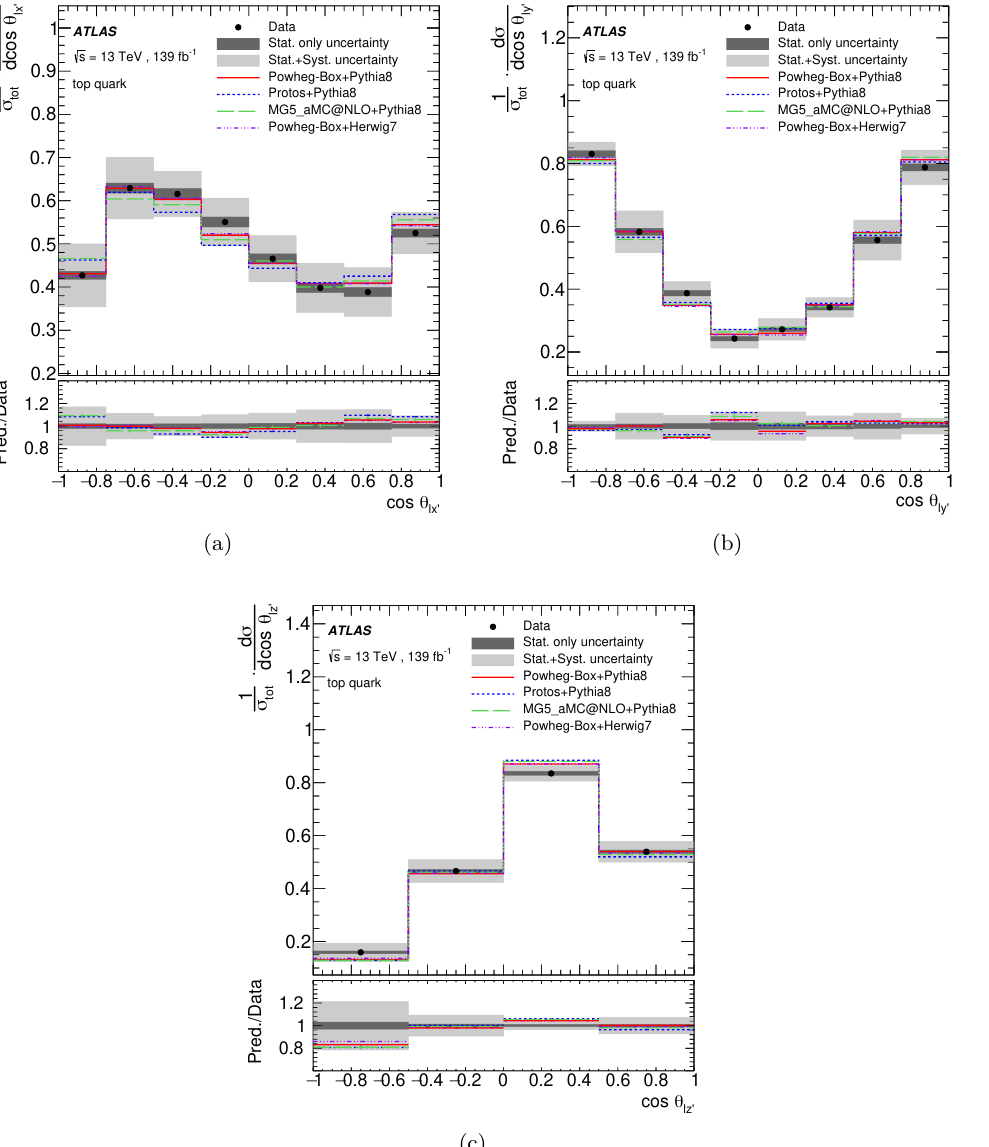
Figure 8 . Particle-level normalised differential cross-sections as a function of (a) cos θ ‘x 0 , (b) cos θ , and (c) cos θ , along with various SM MC predictions of the t -channel signal for top ‘y 0 ‘z 0 quarks. The data, shown as the black points with statistical uncertainties, are compared with predic- tions (lines) obtained by using the Powheg Box + Pythia 8 (solid red), Protos + Pythia 8 (dashed blue), MadGraph5_aMC@NLO+Pythia 8 (long-dashed green) and Powheg Box + Herwig 7 (dot-dashed violet) generators. The uncertainty bands include both the statistical and systematic uncertainties. The data statistical uncertainty is too small to be visible. The lower panels show the ratio of prediction to data in each